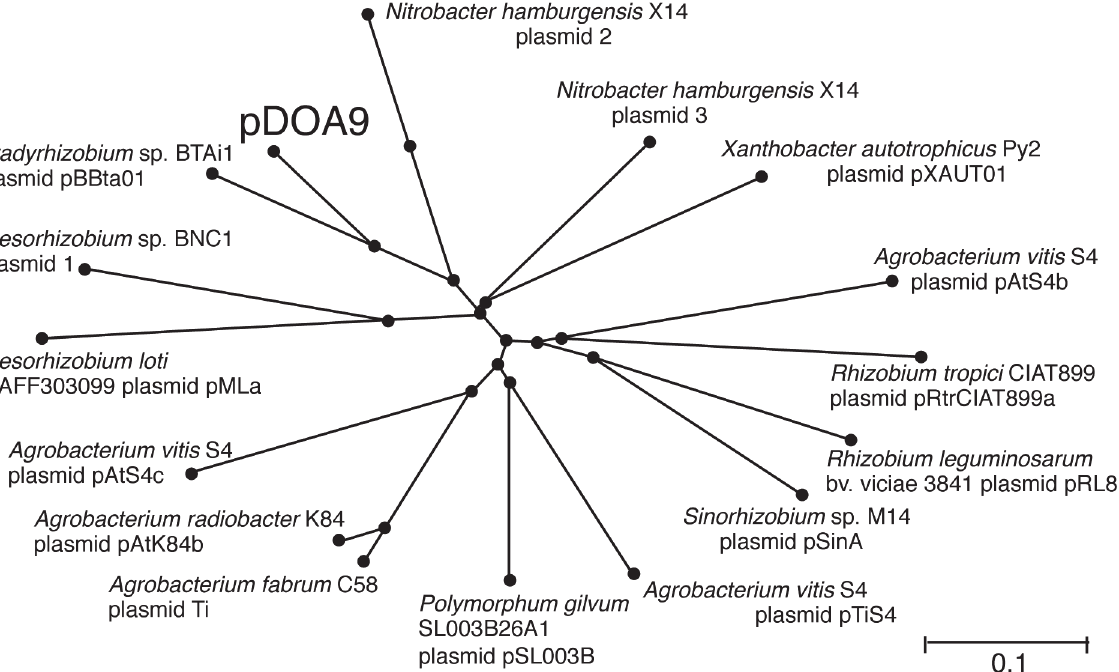
Fig 5. Phylogenetic relationships of pDOA9 and related plasmids. Bootstrap values are expressed as percentages of 1,000 replications. Evolutionary distances were computed using the Kimura two-parameter method. The bar represents one estimated substitution per 100-nucleotide